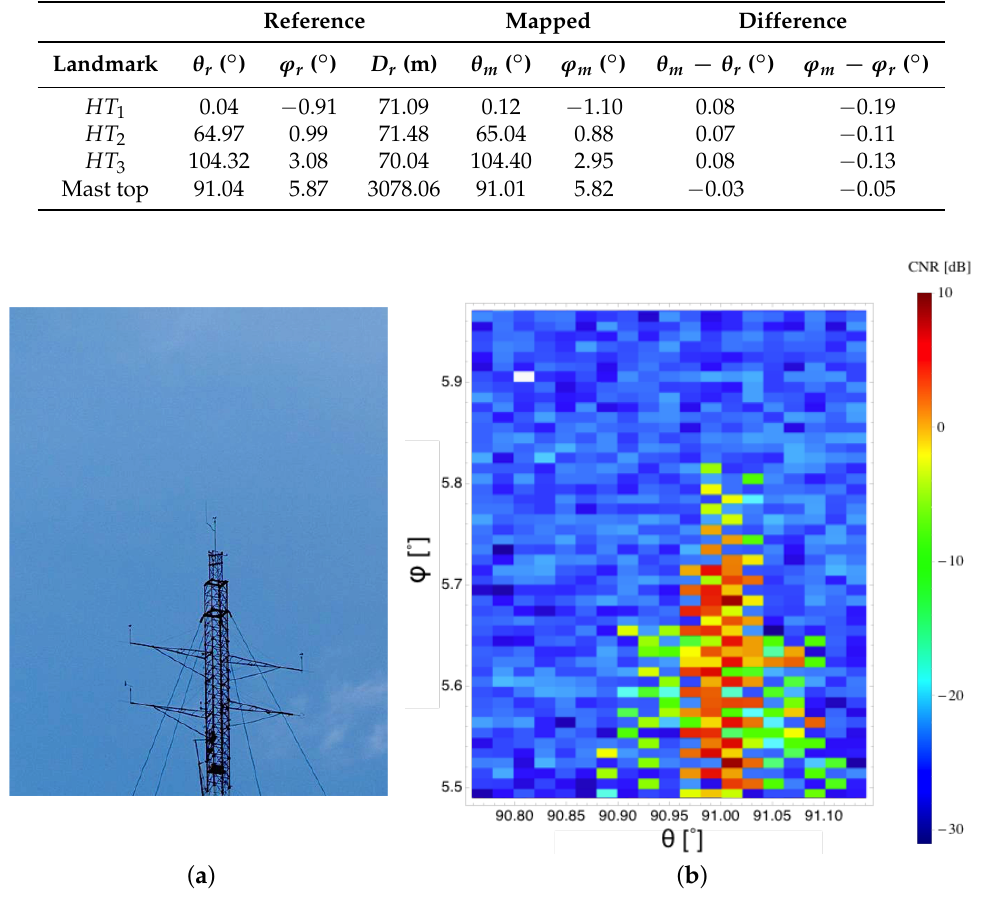
Figure 15. Mapping mast top. ( a ) Mast top; ( b ) CNR map (azimuth angle, θ ; elevation angle, ϕ